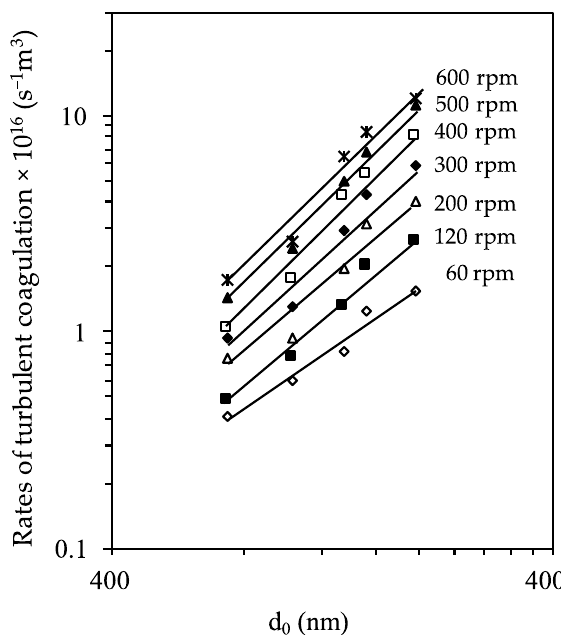
Figure 5. Rate of turbulent coagulation as a function of primary particle diameter for different rotation speeds (60 ( ), 120 ( ), 200 ( ), 300 ( ), 400 ( ), 500 ( ), and 600 ( ) [rpm]).